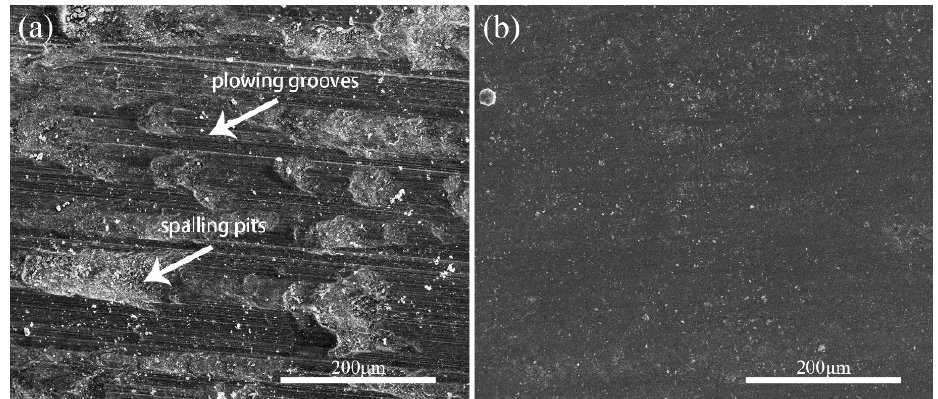
Figure 14. Typical worn surface morphologies of different claddings: ( a ) Coating 1; ( b ) Coating 2.